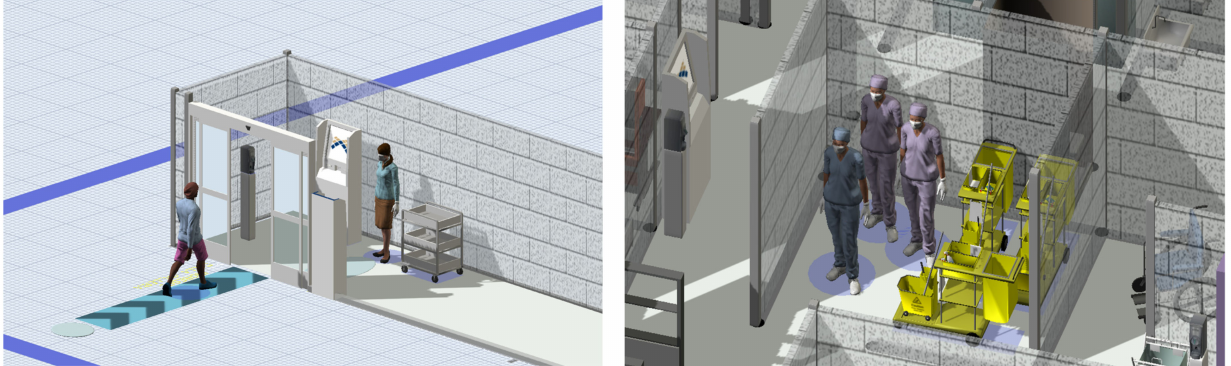
Figure 4. 3D views of the pandemic model of the GSD SC. On the left, patient and clerk performing the pre-registration step (hand disinfection, temperature control and protective equipment wearing) at the SC entrance. On the right, cleaning staff and carts dedicated to the sanitation